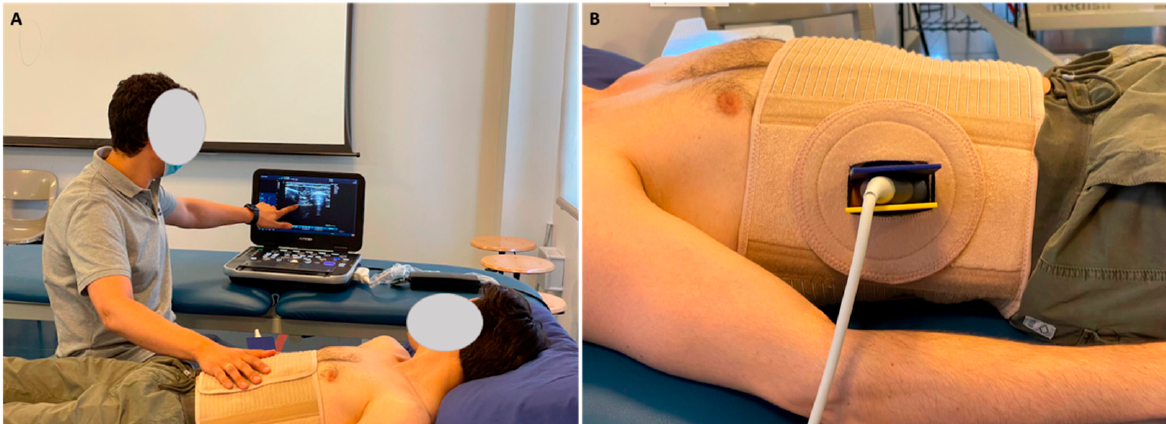
Figure 2. Ultrasound visual biofeedback by RUSI within the proposed orthosis device. ( A ) Ultrasound visual biofeedback by RUSI using the holding device to fix the ultrasound probe to the proposed orthosis device. ( B ) Adapter for fixation and support of the linear ultrasound probe placed perpendicular to the last intercostal space following the mid-axillary line.